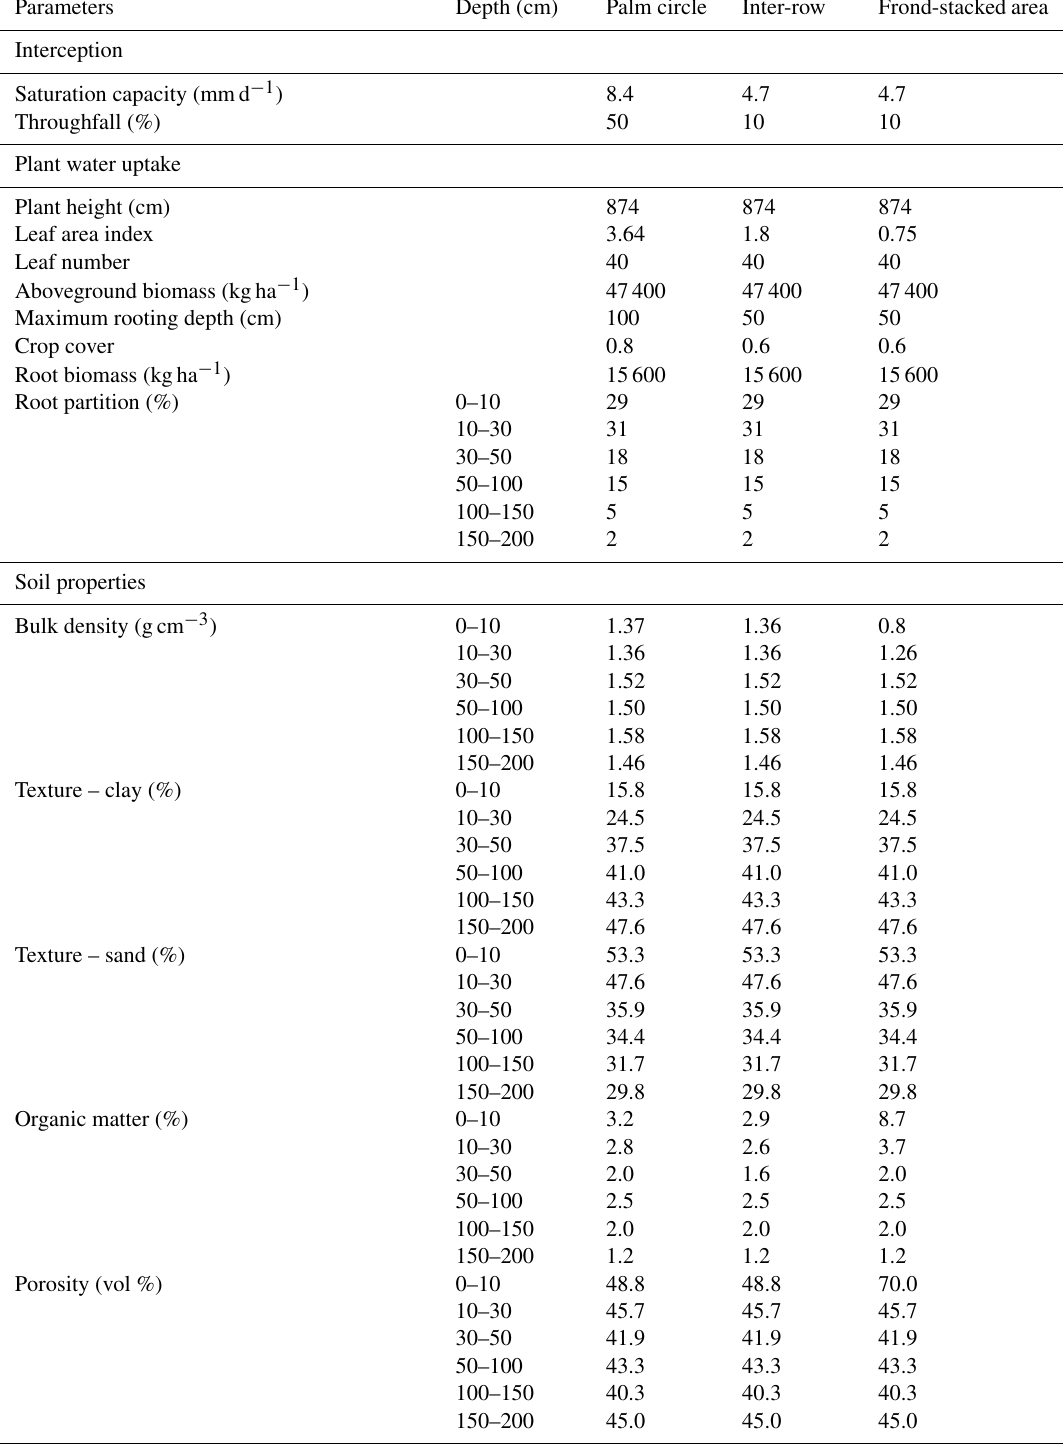
Table A1. Parameters used in the Expert-N water sub-model for each management